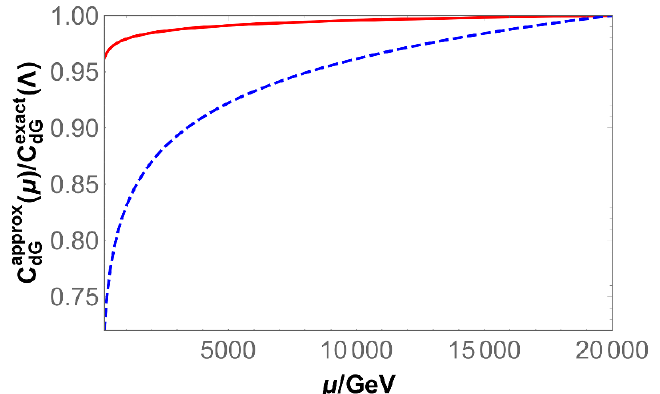
Figure 3 . Comparison of the approximations discussed in the text, taking the scale-dependence of the ADM into account (red) or not (blue dashed). Shown is the mixing of C tG into C dG relative to the exact